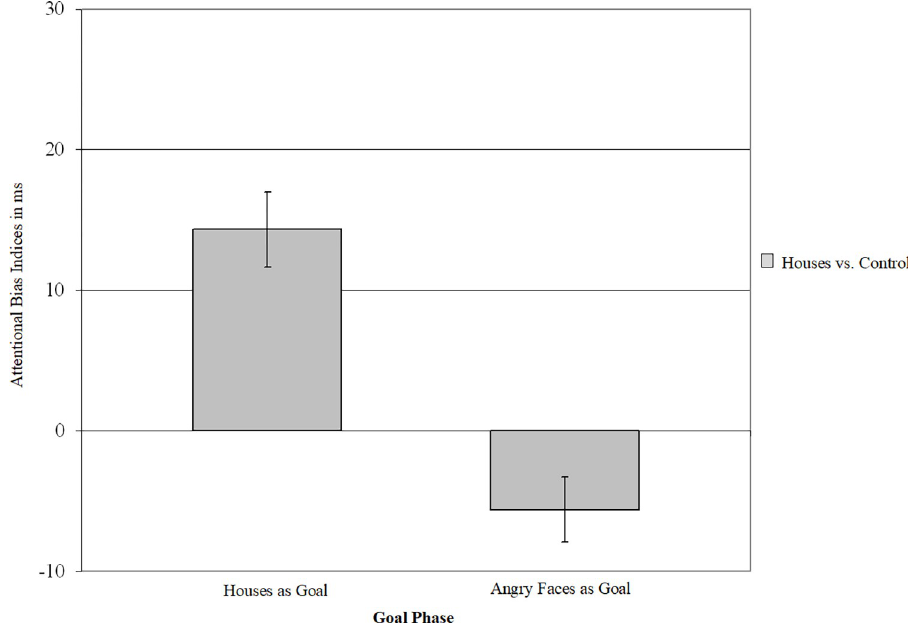
Fig 3. Attentional bias indices for trials presenting houses. Houses were presented in comparison to control car stimuli in house goal and angry face goal phases. Positive attentional bias indices indicate attention towards houses, negative attentional bias indices attention towards control car stimuli. Error bars represent standard errors of